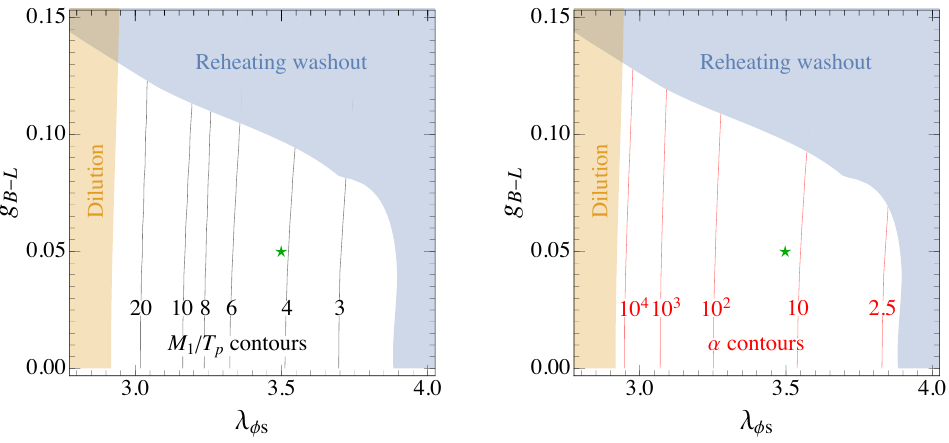
Figure 2 . The allowed parameter space of the FOPT leptogenesis scenario is shown in white region, for M 1 = 2 . 5 × 10 11 GeV, λ R, 1 = 0 . 3 and λ R, 2 = λ R, 3 = 4 λ R, 1 . The blue and orange shaded regions are excluded by thermal washout and dilution effects after the FOPT reheating, respectively. The M 1 /T p and α contours are shown in the left and right panels, respectively. The green star is the benchmark adopted for GW calculation, see figure 3 for